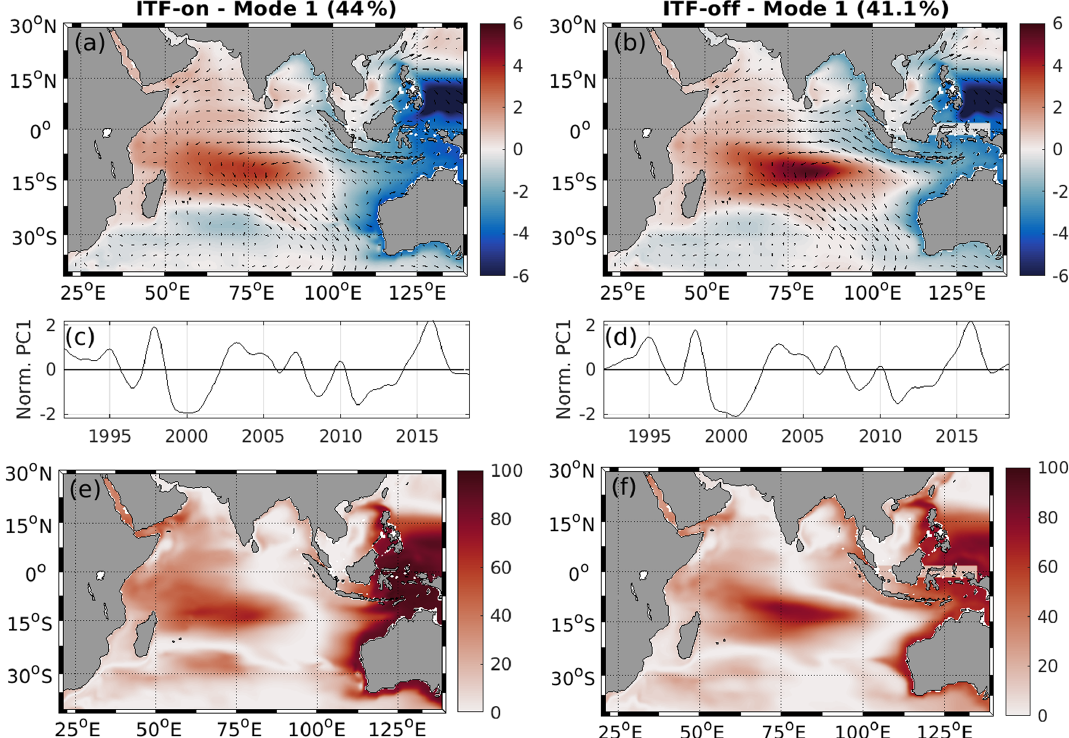
Figure 6. Regression of monthly SLA (color) and wind stress (arrow) on the standardized principal component of the first EOF mode (PC1) from 1992 to 2018 for the ITF-on (a) and ITF-off (b) simulations, expressed in centimeters per 1SD of change of the respective PC1. (c, d) Time evolution of the associated PC1 normalized by their standard deviations. (e, f) Explained variance between the modeled and the reconstructed